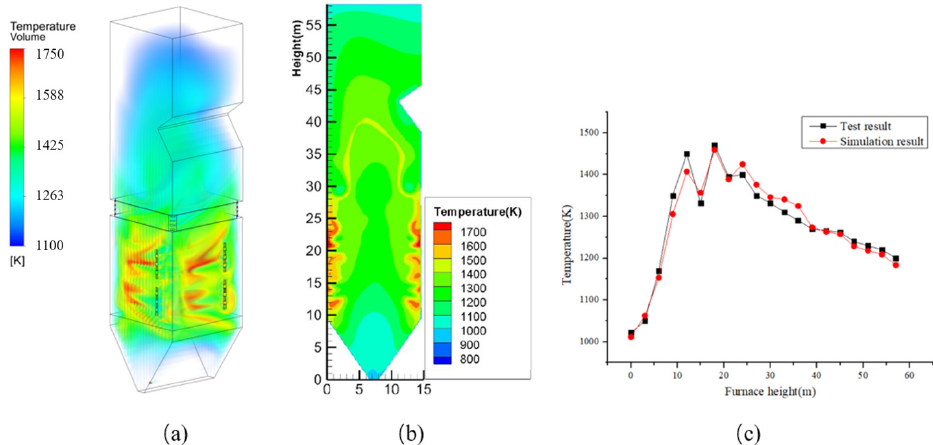
Figure 5. Distribution diagram of longitudinal temperature in furnace. ( a ) Fluid domain temperature field. ( b ) Temperature cloud of central longitudinal section. ( c ) Curve of average temperature of furnace cross section with height.